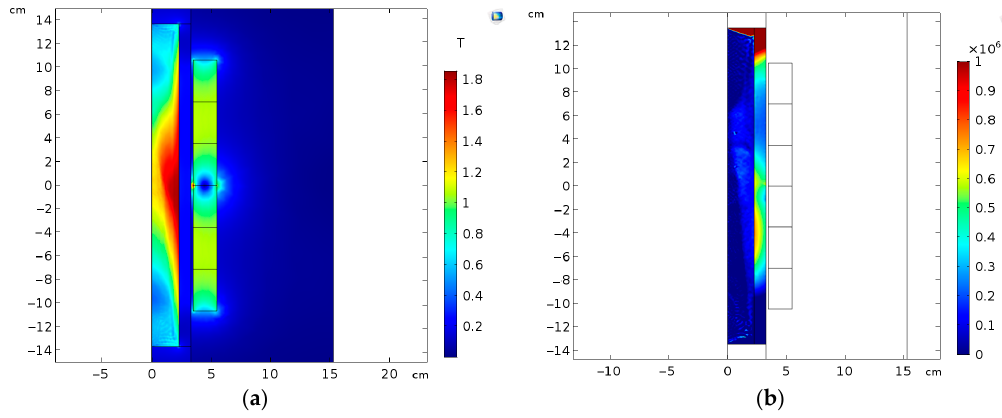
Figure 6. For Model III: ( a ) Magnetic flux density, ( b ) induced current density, at v = 1.0 m/s.